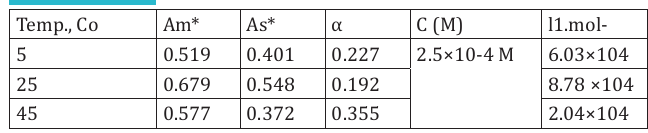
Stability constant at different temperature